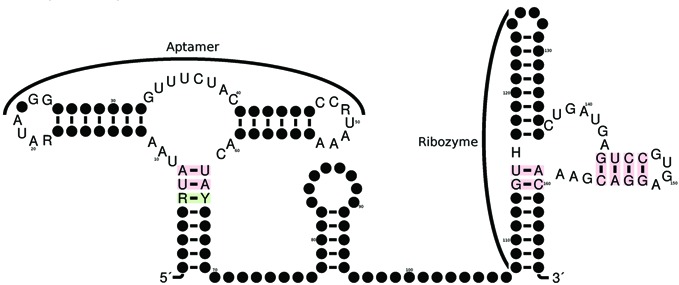
Target secondary structure S for modular placement of artificial hammerhead within larger RNA molecule. The structure and highly conserved nucleotides (sequence constraints) of the XPT-riboswitch appear on the left, while the structure and highly conserved nucleotides of the type III hammerhead ribozyme appear on the right.